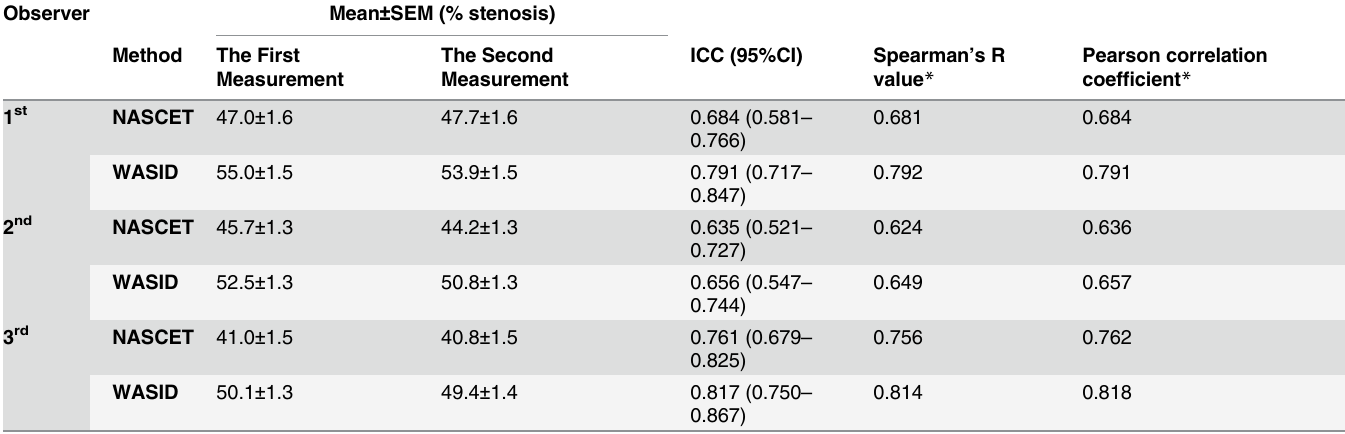
Table 2. Mean ± SEM, ICC, Spearman ’ s R value, and Pearson correlation coefficient statistics of intra-observer agreement.